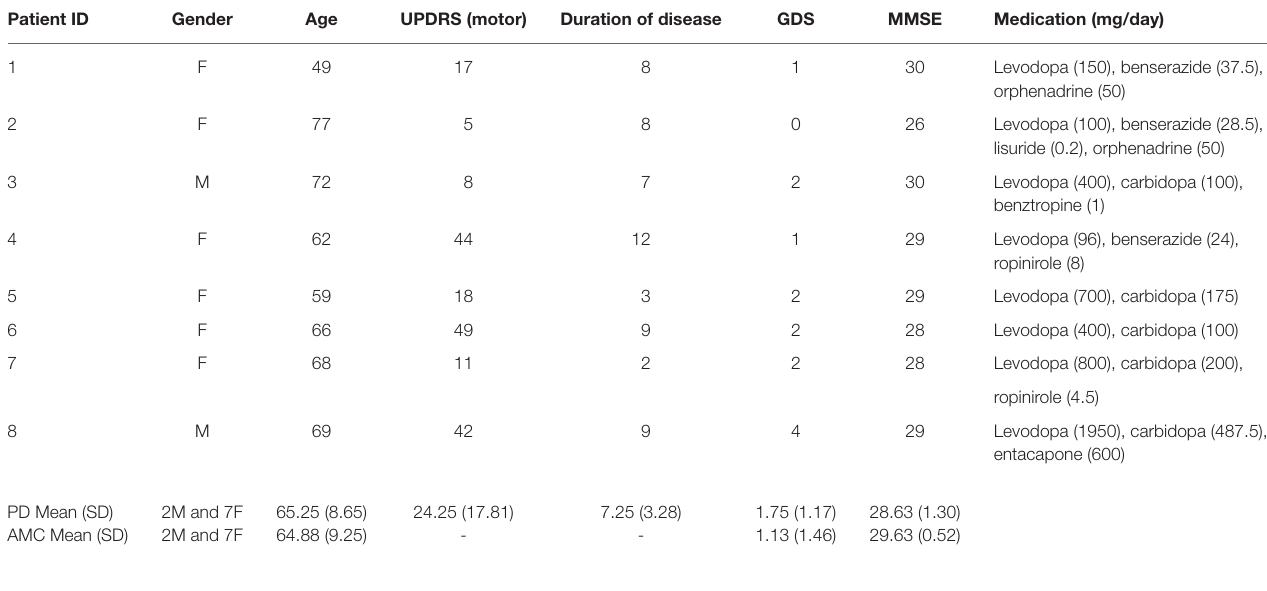
TABLE 1 | Demographic, pathology, and drug details in Parkinson’s disease (PD) patients and controls. Patient